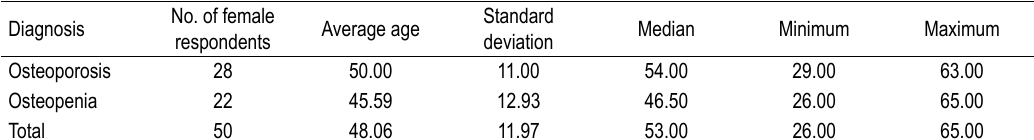
TablE 1. the average age of female respondents based on diagnosis